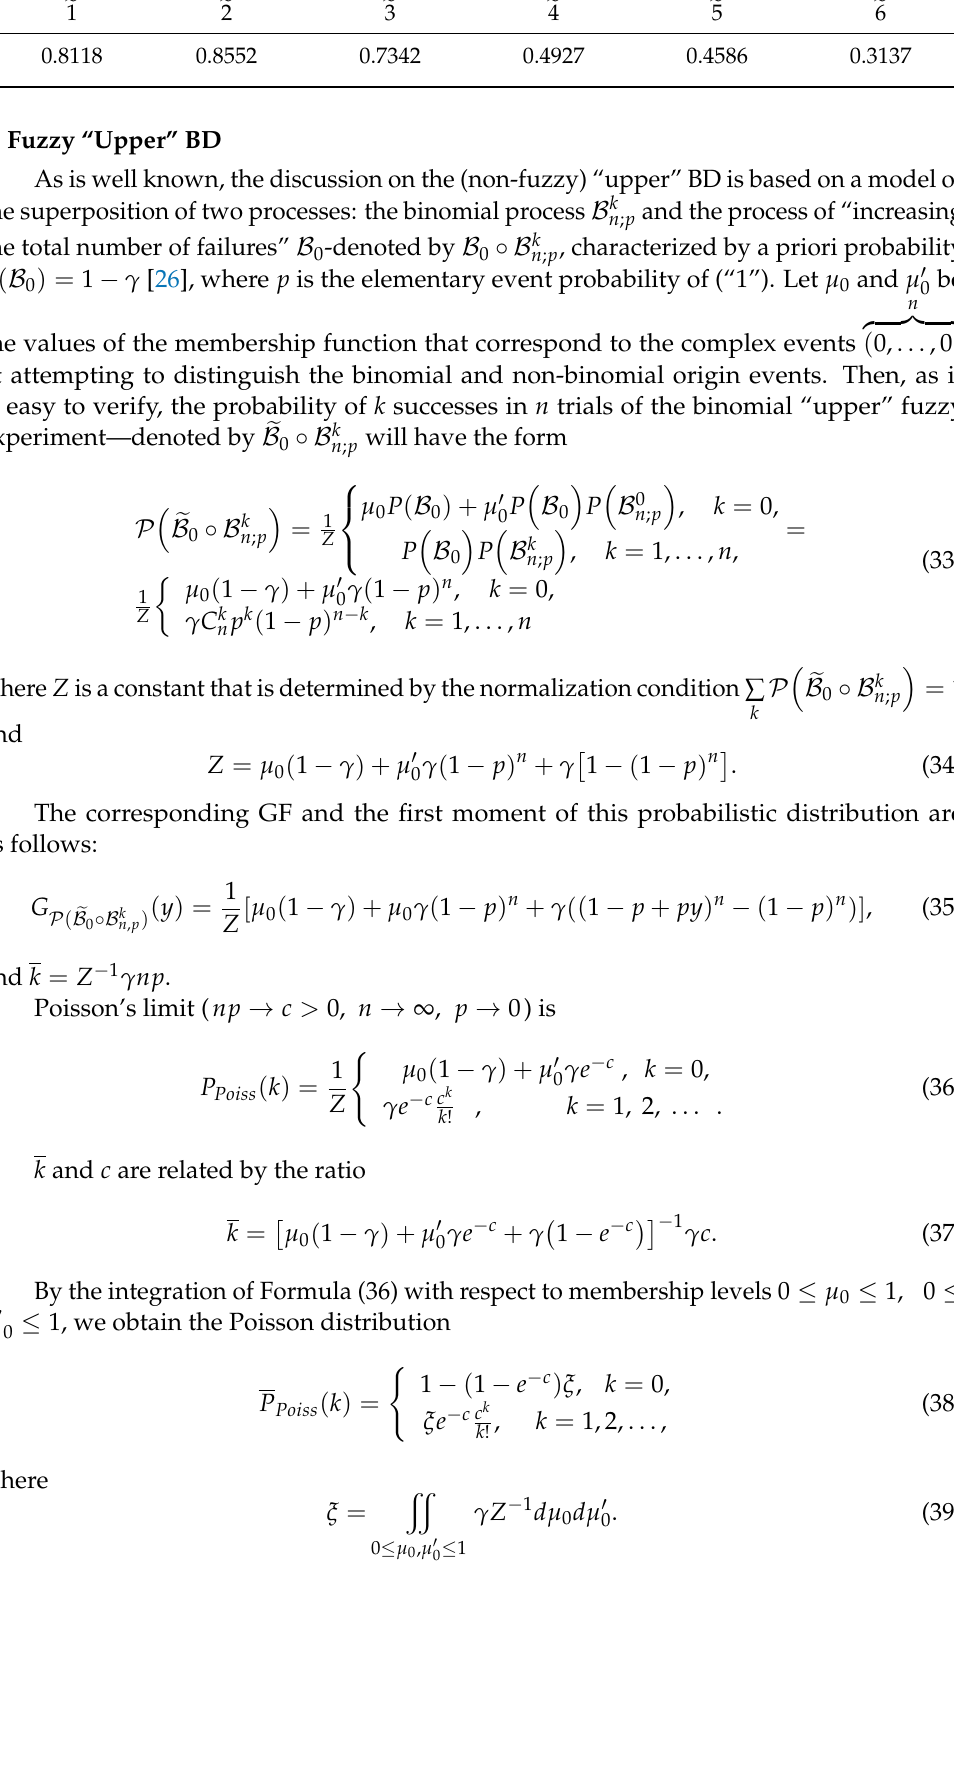
Table 4. Numerical values of BD with fuzzy success numbers— P